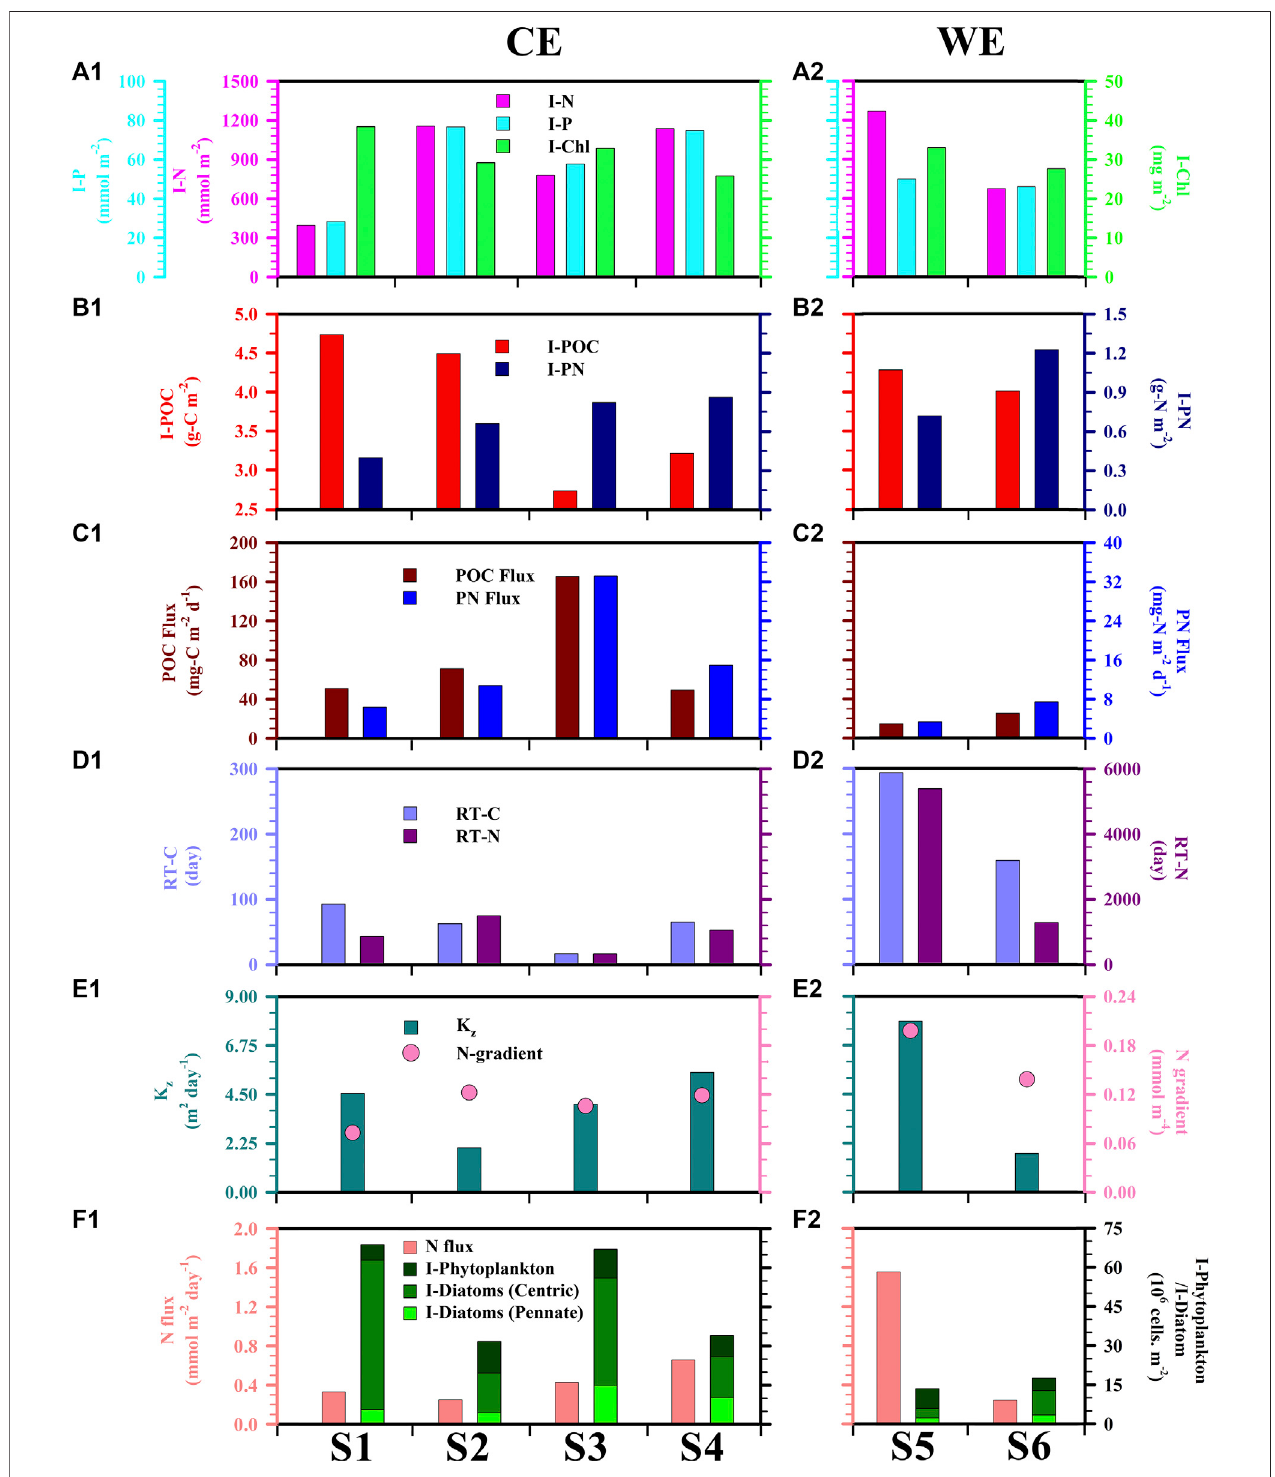
FIGURE4| Depth-integrated(0 – 150 m)valuesof (A) nitrate+nitrite(N),phosphate (P),chlorophyll(Chl)and (B) POCandPN; (C) POCandPN fl uxesmeasuredat adepthof150 m; (D) Retention timesofcarbon(RT-C)andnitrogen (RT-N)intheupper150 mrepresentinghowlongitwouldtakeforsedimentationbyitselftoremove all ofPOC and PN from the water column (RT-C (cid:2) I-POC/POC fl ux; RT-N (cid:2) I-PN/PN fl ux); (E) Vertical eddy diffusion coef fi cient (K z ) between MLD and 150-m depth and correspondingnitrate+nitrite (N)concentration gradient; (F) Totalphytoplanktonand diatominventories (0 – 100 m) (I-Phytoplankton/I-Diatom), andnitrite +nitrate fl ux (N fl ux) due to turbulent mixing.